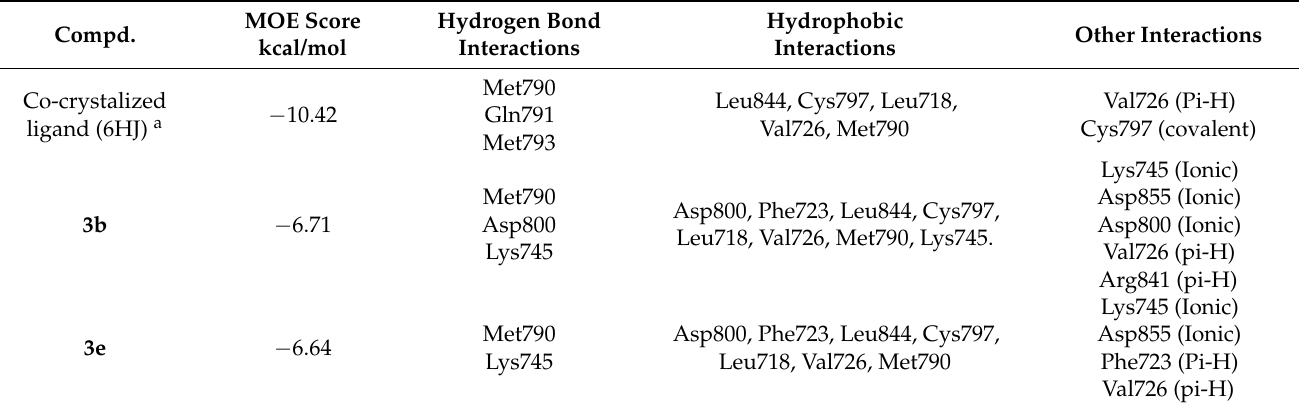
( C ) Figure 3. Docking representation models for compounds 3b and 3e ; ( A ): 3D-docked models of com- pound 3b (purple) aligned with 3e (green) within the active site of EGFR T790M showing the interac- tion surface of the protein (electrostatics; green: hydrophobic, blue: positive, and red: negative); ( B ): 2D-docked model of compound 3b within the active site of EGFR T790M ; ( C ): 2D-docked model of compound 3e within the active site of EGFR T790M . 2.4. In Silico ADME/Pharmacokinetics Studies